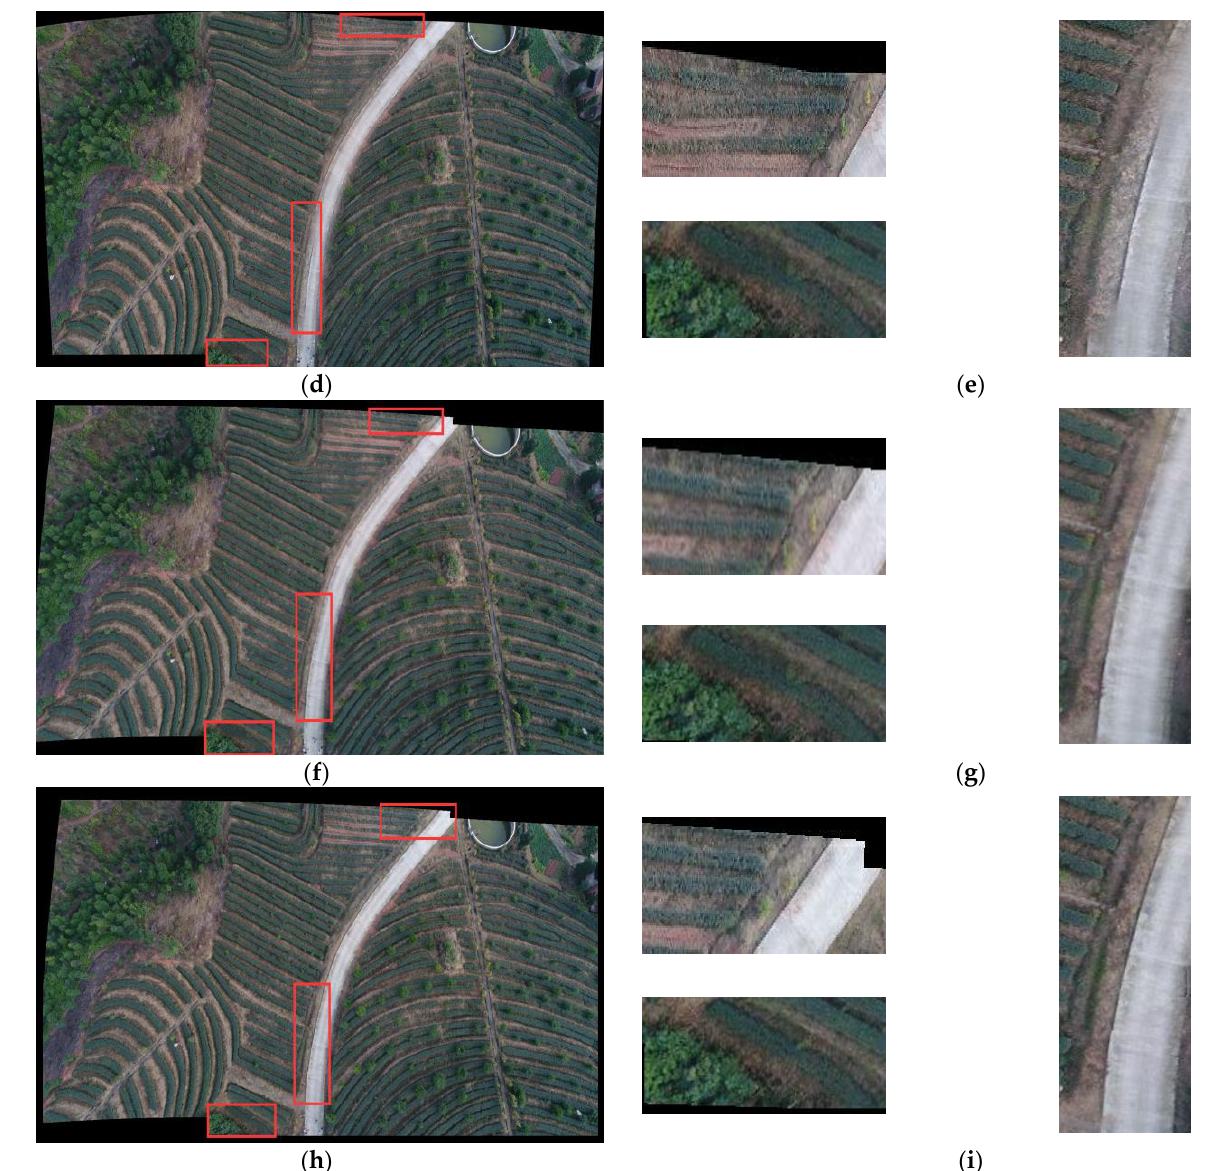
Figure 10. Results of AutoStitch, AANAP and the algorithms used in this study. ( a ) Reference images; ( b ) target image; ( c ) suture line results of ( a ) and ( b ) in this study; ( d ) results in AutoStitch; ( e ) magnified images in red frames of ( d ); ( f ) results in AANAP; ( g ) magnified images in red frames of ( f ); ( h ) results in this study; and ( i ) magnified images in red frames of ( h ).